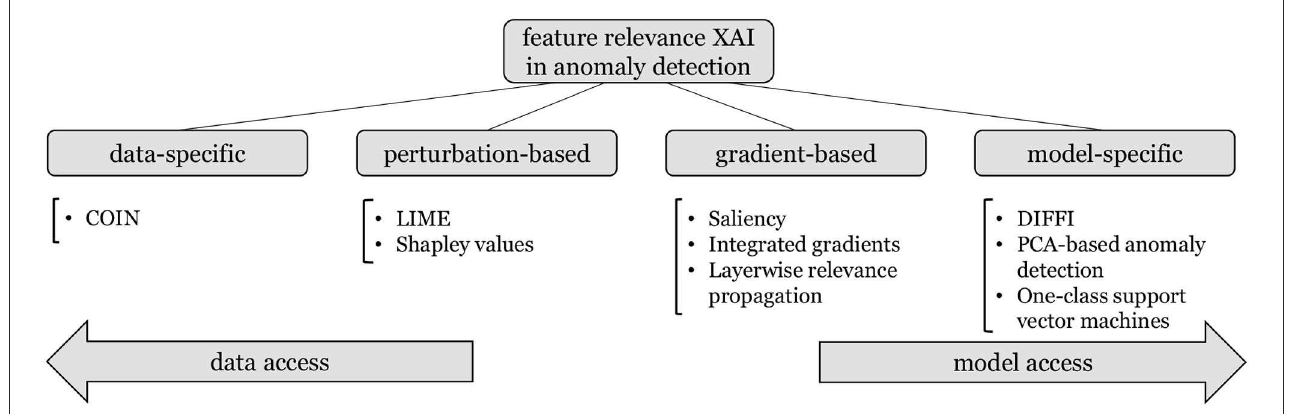
FIGURE1 Overview of the reviewed feature relevance approaches in anomaly detection, structured by their use of information from data and from the underlying anomaly detection